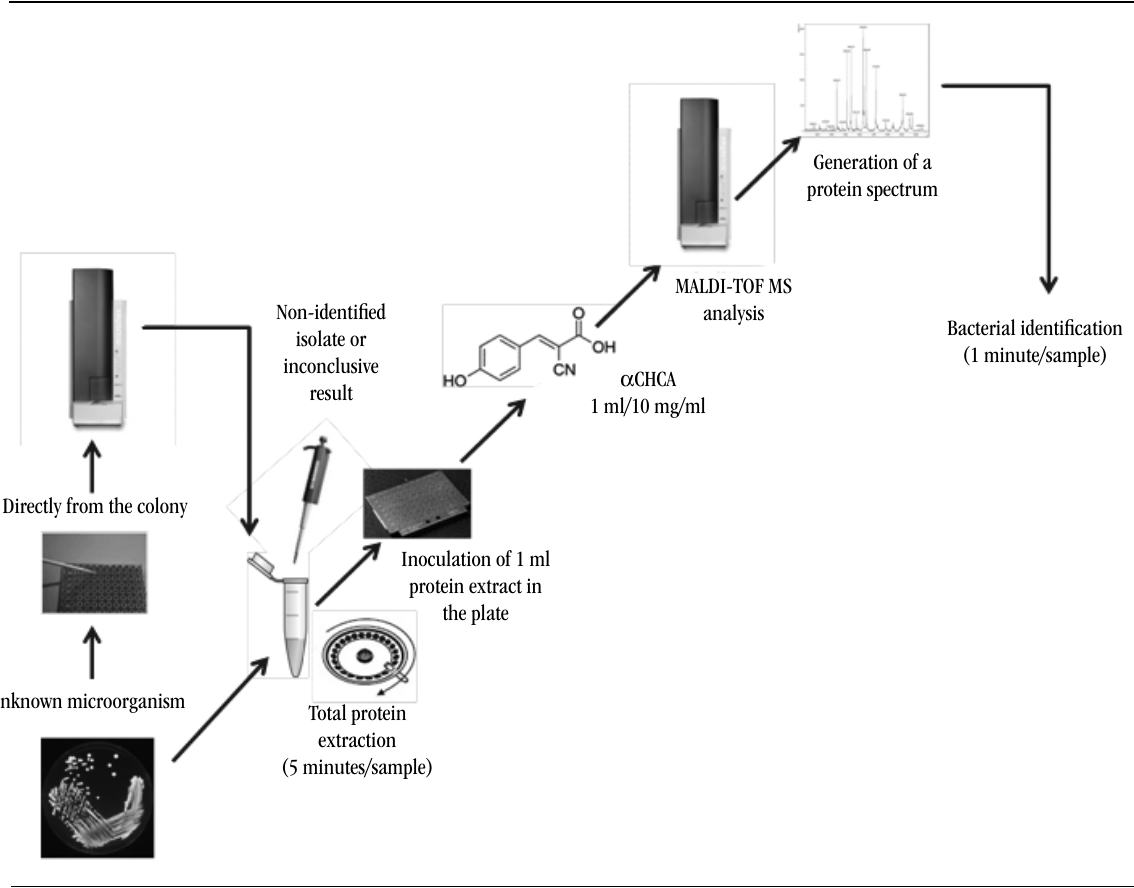
figurE 2 – Flowchart of the use of MALDI-TOF MS in microorganism identification at the clinical microbiology laboratory MALDI-TOF MS: matrix assisted laser desorption/ionization-time of flight mass spectrometry; α CHCA: alpha-cyano-4-hydroxycinnamic acid.